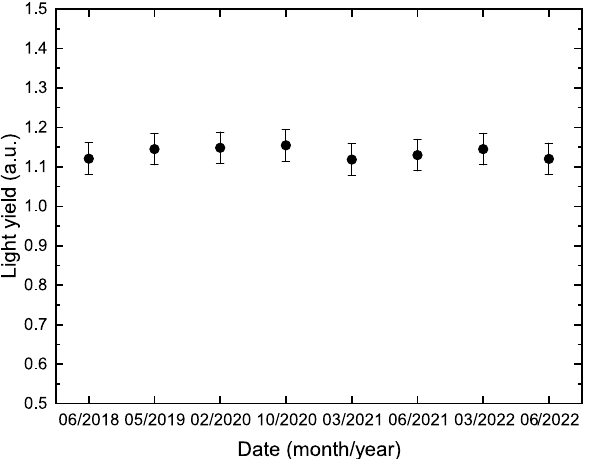
Fig. 7 Light yield of the developed LAB-based scintillator with NOL 37 kept stable between June 2018 and June 2022